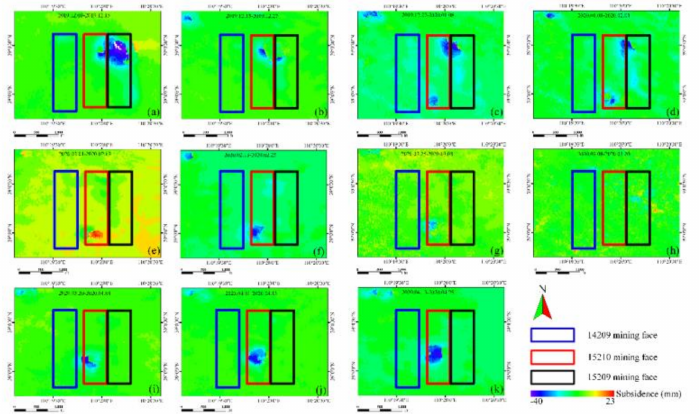
Figure 5. Subsidence of the study area based on SBAS-InSAR technology by period (A negative value represents a subsidence and a positive value means an uplift) ( a – k ).